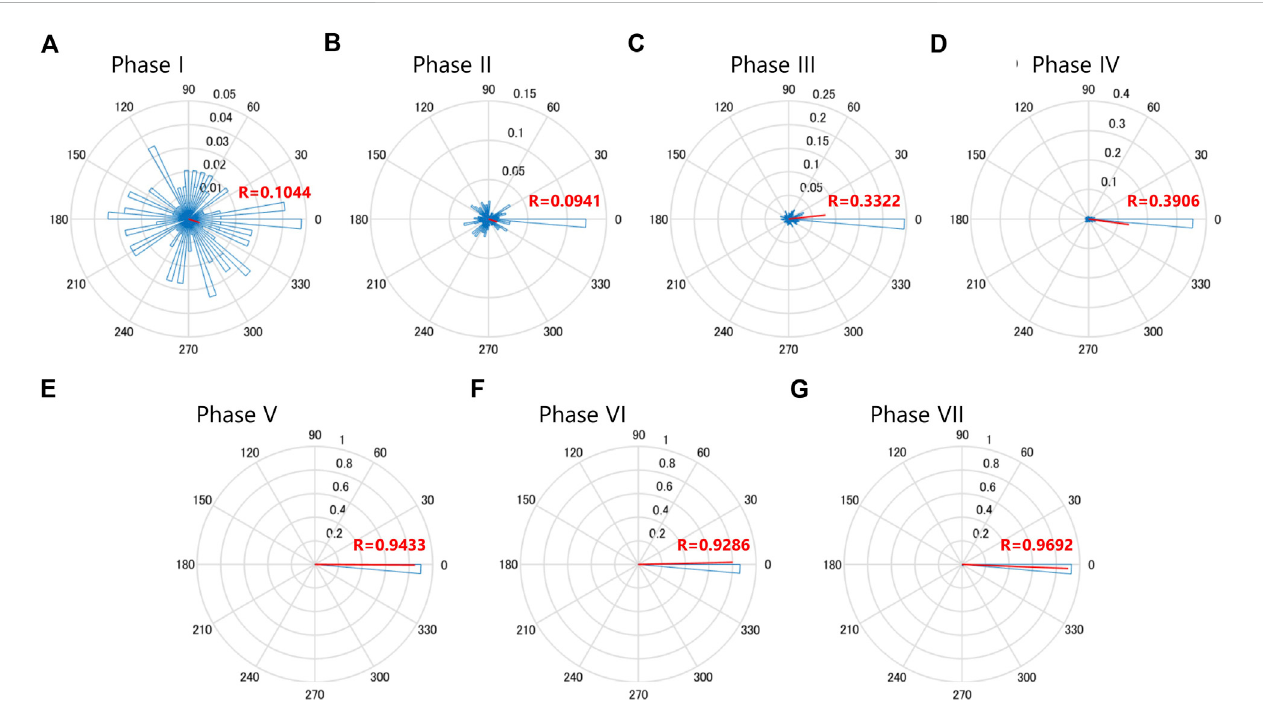
FIGURE 4 MN2L and MN2R Ca 2+ transients gradually synchronize as they develop into swimming larvae. Rayleigh ’ s test of uniformity for the MN2L and MN2R Ca 2+ transients. Time point of the MN2R peak is assigned as a phase value of 0 ° , and that of the next MN2R is assigned as a phase value of 360 ° . The Phase values of MN2LCa 2+ burstpeaktimingsareplottedasthebluehistograms,andtheaveragevaluesareshownasthevector(redlines).Thedirectionofthevectorshows themeanoftheMN2LPhasevalue,whereasthelengthofthevector(0 & R & 1)showstheuniformityofMN2LburstPhasevalues. (A) PhaseI,mean-18.3 ° , R = 0.104, n = 145. (B) Phase Ⅱ , mean -18.4 ° , R = 0.0941, n = 59. (C) Phase Ⅲ , mean 6.17 ° , R = 0.332, n = 132. (D) Phase IV, mean -7.78 ° , R = 0.391, n = 334. (E) Phase V, mean -0.359 ° , R = 0.943, n = 49. (F) Phase VI, mean 1.27 ° , R = 0.929, n = 99. (G) Phase VII, mean -3.00 ° , R = 0.969, n =